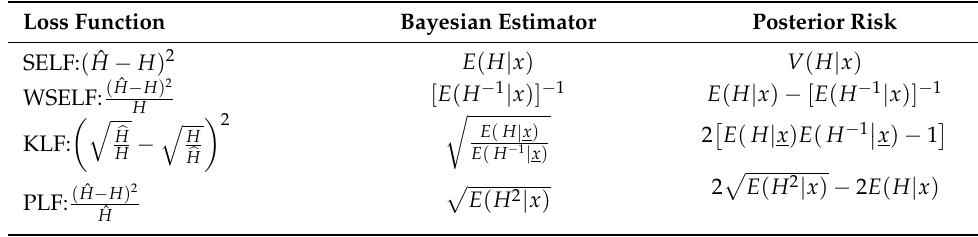
Table 1. Bayesian estimators and corresponding posterior risks of different loss functions. Loss Function Bayesian Estimator Posterior